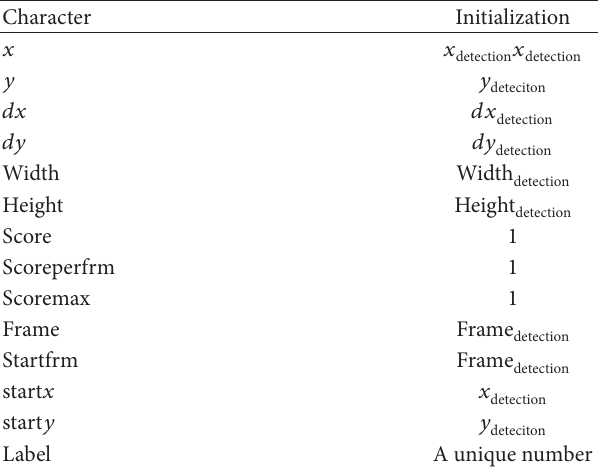
Figure 12: A new scatter gram of the frequency of the template samples in 𝑥 -axis. Table 2: Template initialization.